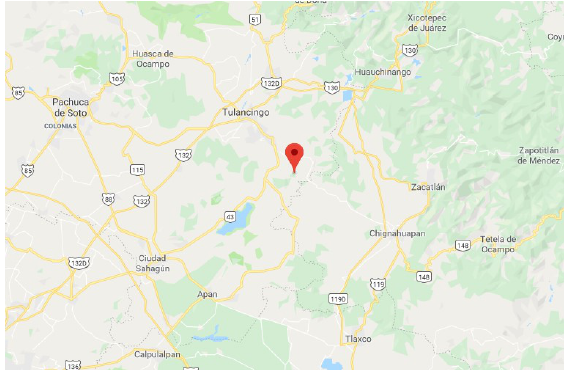
Figure 7. New facility location